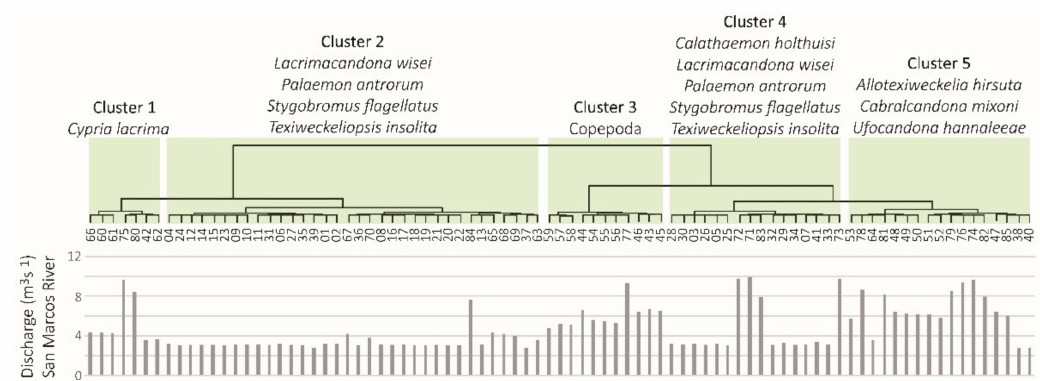
Figure 4. Ward’s minimum variance dendrogram of high-frequency sample stygobiont community data from the San Marcos Artesian Well, with corresponding discharge from the nearby San Marcos River. Sample numbers (dendrogram tips) refer to sample order (e.g., 01 occurred at T 0 , followed by 02) but time between consecutive samples is variable. Significant groupings are demarcated by shading, and significantly associated taxa are shown above. Discharge is not represented by a hydrograph because samples are clustered by community similarity and are not shown in chronological